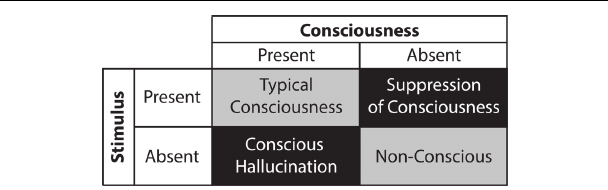
FIGURE 5 | Balanced experimental design using instrumental hypnosis where contrast between conscious suppression – i.e., stimulus is present and consciousness is absent – and conscious hallucination – i.e., stimulus is absent and consciousness is present – enable targeting of neural correlates of